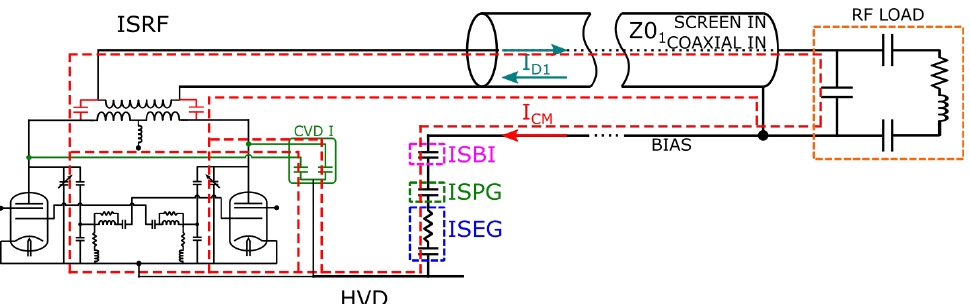
Figure 5. Common mode current path with CVD installed at RF transformer primary side.